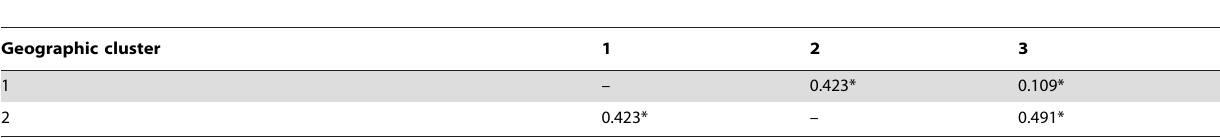
Table 4. Pairwise F ST values calculated for the three-population geographical model observed with Hudson’s Permtest.